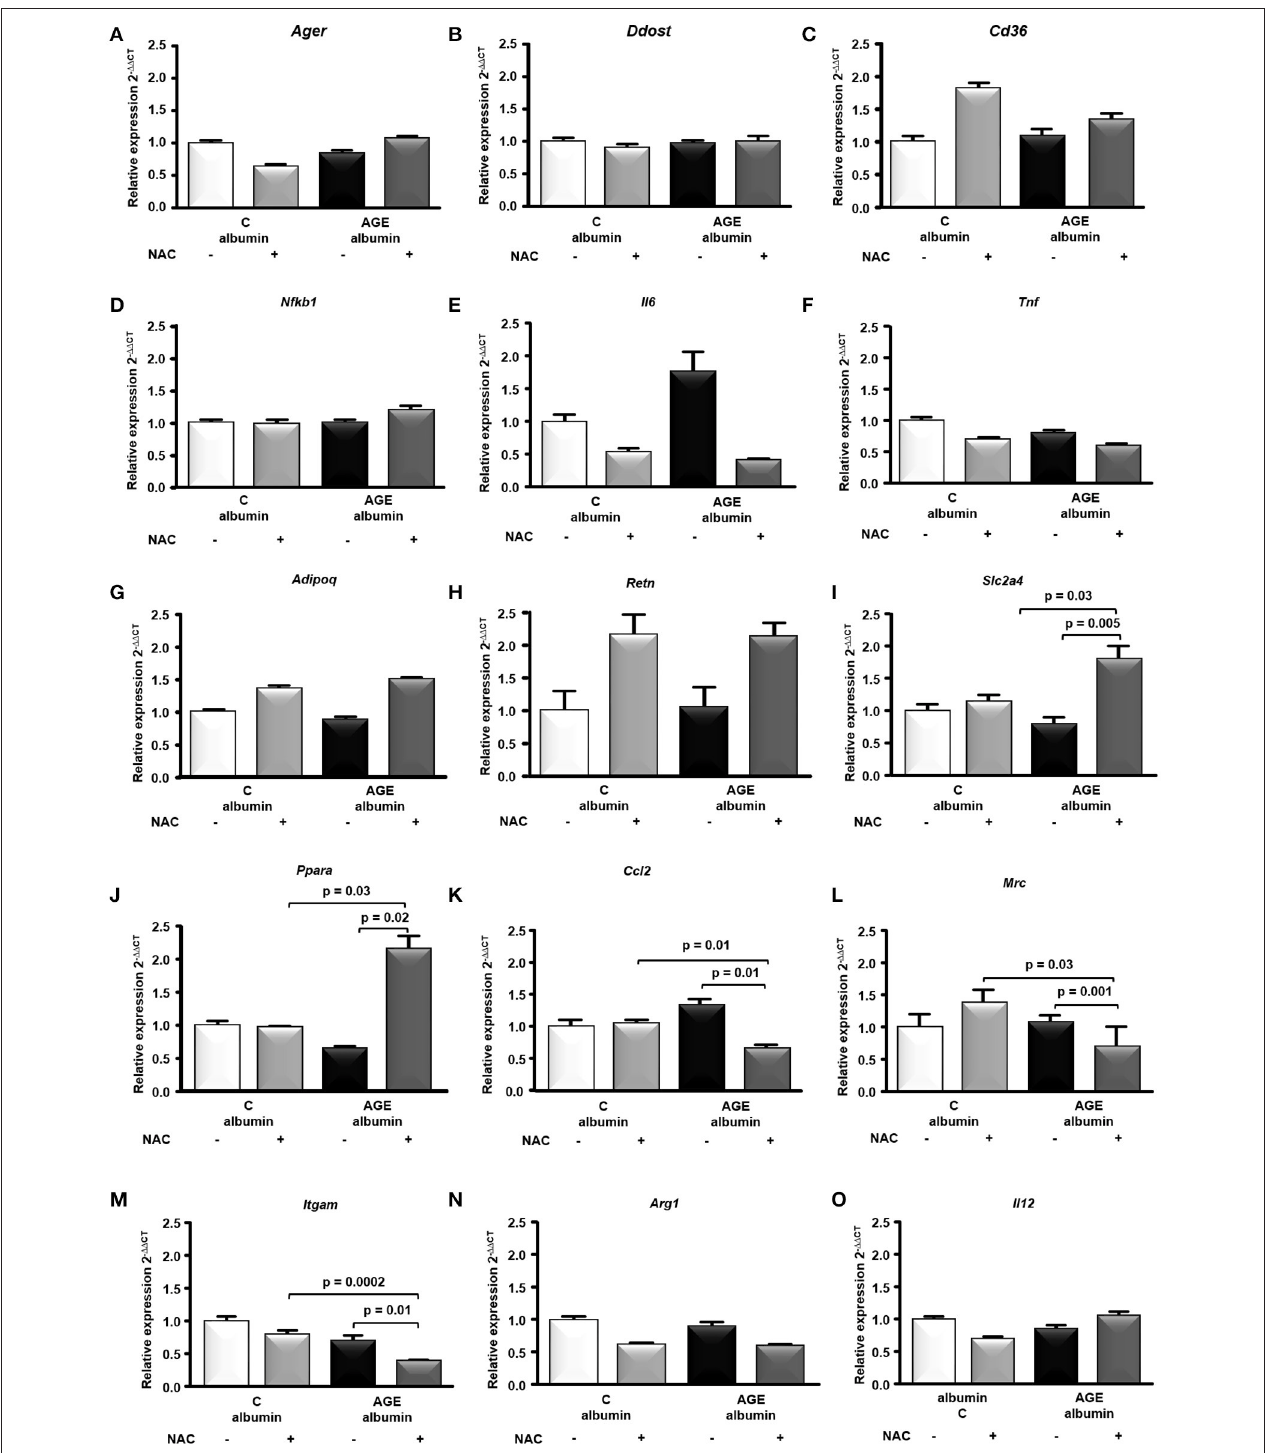
FIGURE 5 | Gene expression in periepididymal adipose tissue. Ager (A) , Ddost (B) , Cd36 (C) , Nfkb1 (D) , Il6 (E) , Tnf (F) Adipoq (G) , Retn (H) , Slc2a4 (I) , Ppara (J) , Ccl2 (K) , Mrc (L) , Itgam (M) , Arg1 (N) , Il12 (O) mRNA were evaluated in periepididymal adipose tissue from animals treated with C-albumin ( n = 8), C-albumin + NAC ( n = 7), AGE-albumin ( n = 8) and AGE-albumin + NAC ( n = 7), by real time quantitative PCR (RT-qPCR; Applied Biosystems, Foster City, CA, USA). The relative expression of each gene was normalized to the housekeeping Hprt1 gene and relative quantification analysis was performed using the comparative cycle threshold (Ct) (2 − 11 Ct ) method. Results (mean ± SEM) were compared by One-way ANOVA with Newman-Keuls post-test or Kruskal-Wallis followed by multiple Dunns test.